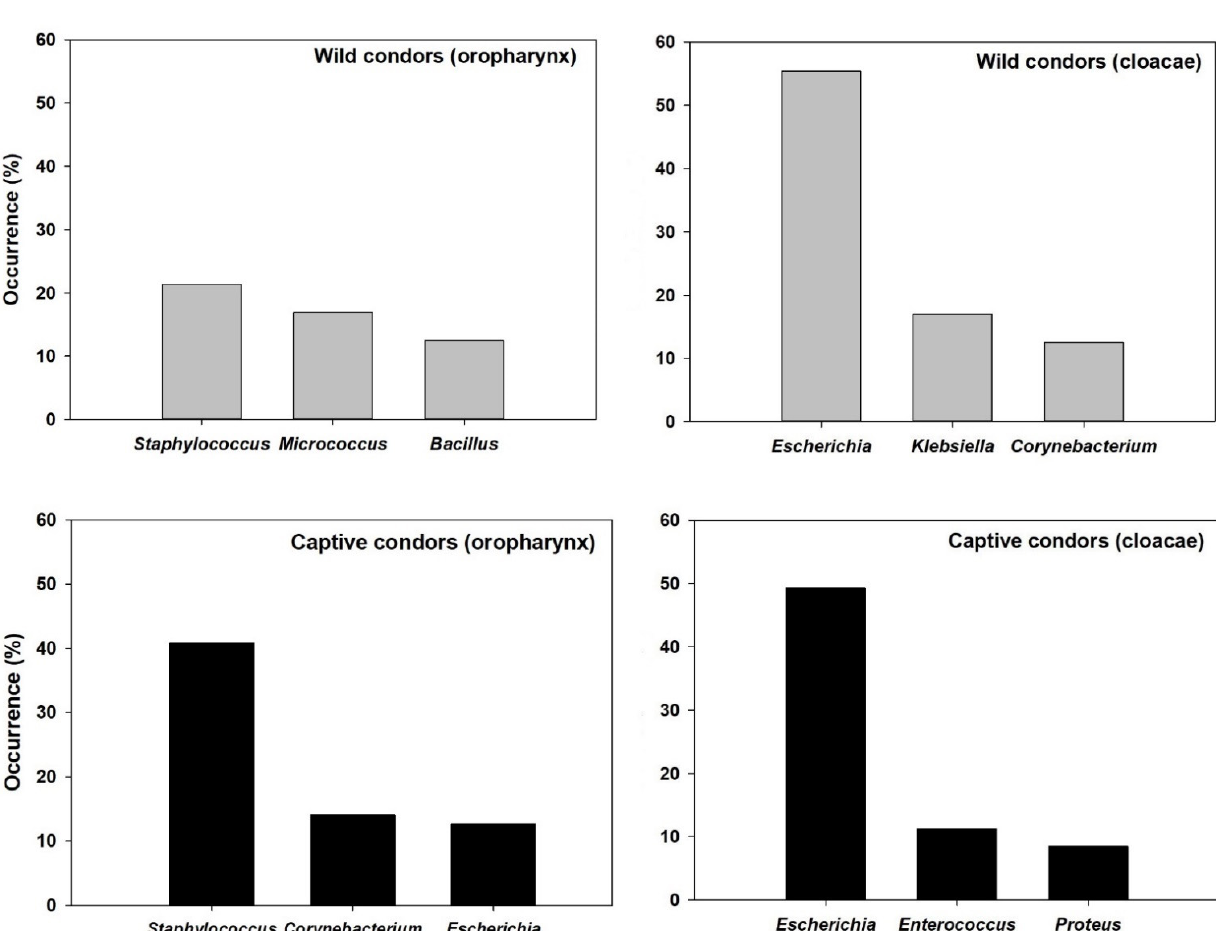
Figure 1. Occurrence of the most representative genus isolated in the oropharynx and cloacae of wild and captive condors. Finally, our comparison between vulture species suggested that the environment where vultures were sampled might influence the occurrence of Salmonella spp. from fecal or cloacae samples, but results are not conclusive (Figures 2 and 3). Vultures of different species and from different geographical areas using anthropized environments showed a tendency to have higher occurrence of Salmonella spp. In fact, when pooling all studied vulture species according to the environment used (vultures using anthropized environ- ments vs vultures using natural environments) and geographical areas (Europe vs Amer- ica) this tendency resulted more notorious, but probably influenced by the large number of studies performed in highly anthropized areas from Europe (Figure 2).